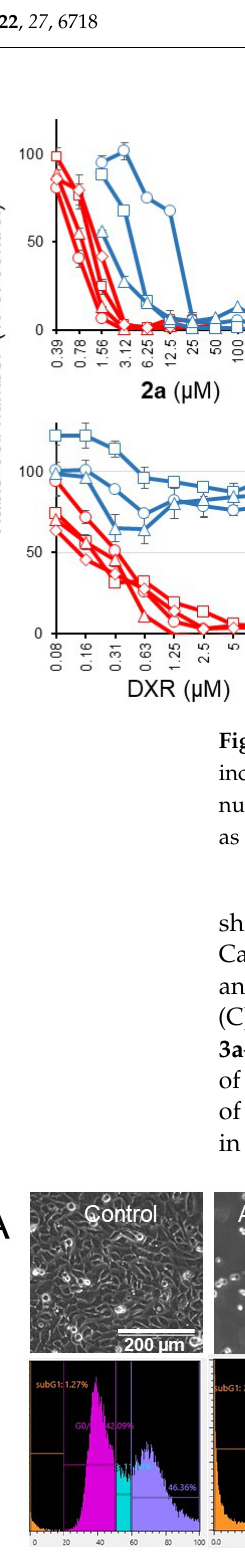
Figure 5. Induction of cell shrinkage ( A ), caspase 3 activation ( B ), and subG1 and G2/M accumula- tion by 2a , 2b , 3a , and 3e . Ca9-22 cells were treated for 24 h with vehicle (control), actinomycin D (Act.D) (1 µM), 2a , 2b , 3a , and 3e (3 µM) in Ca9-22 cells. Each value is represented as the mean ± S.D. of triplicate determinations. * p < 0.05 vs. control (Bonferroni’s post-test) ( C ).